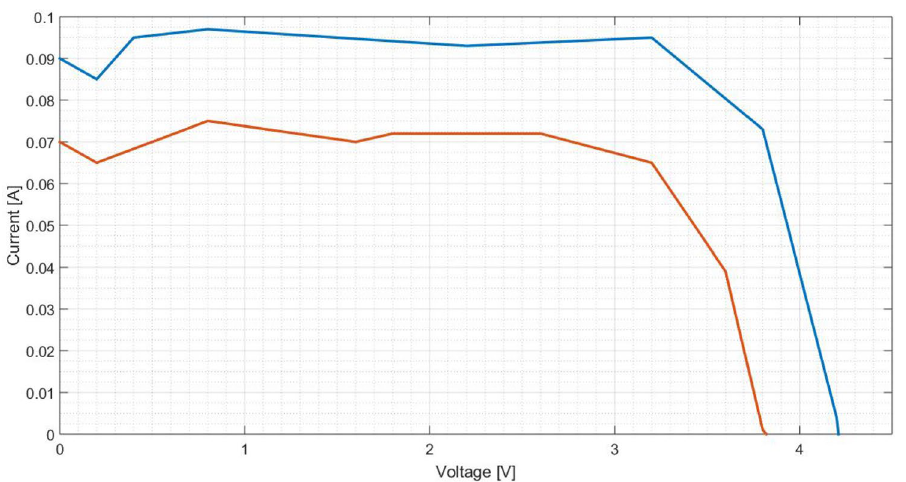
Figure 27. Comparison between I(V) curves of polished aluminium plate (Blue: Day 0; Red: Day